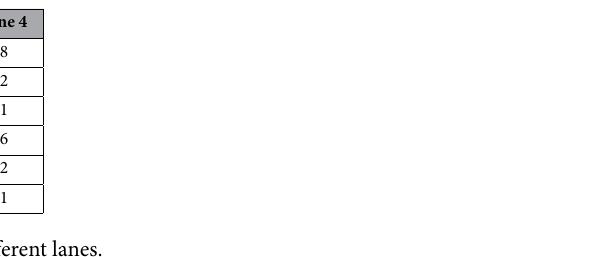
Table 2. Mean value of gust factor at different